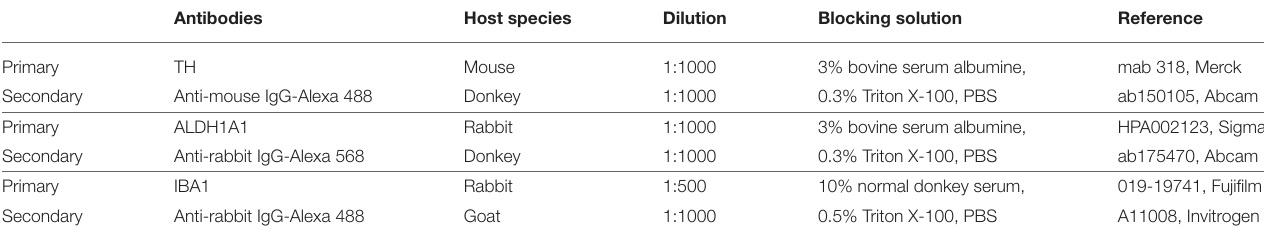
TABLE 2 | Reagents and resources used for immunostaining experimentation. Antibodies Host species Dilution Blocking solution